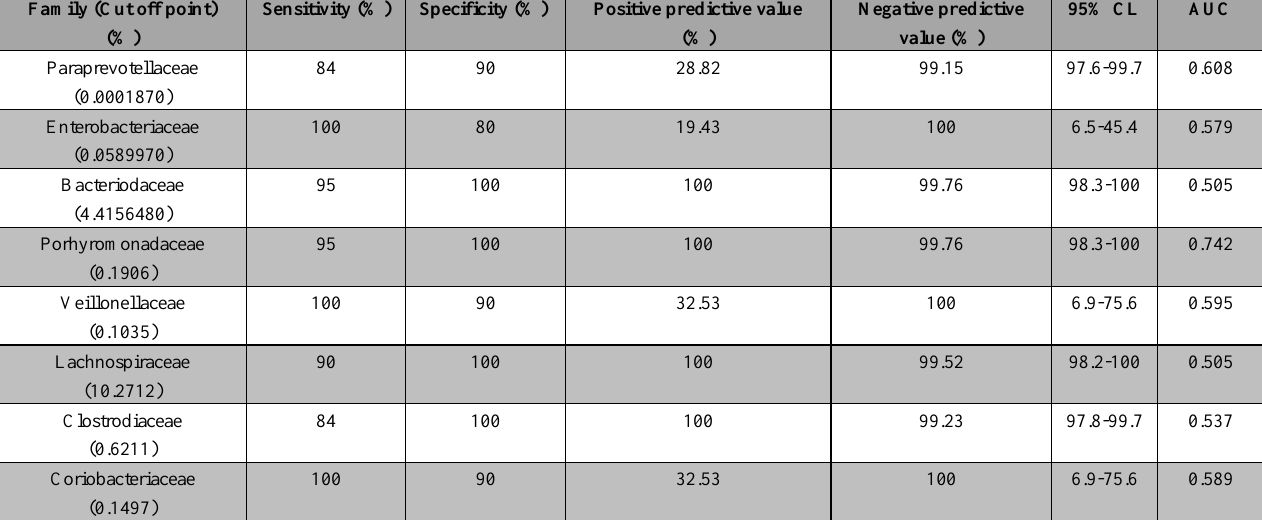
Table 3. Sensitivity, Specificity, and predictive values of the gut microbiome and family for the prediction of